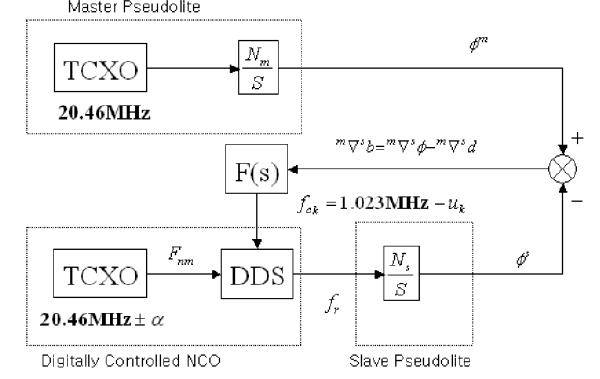
Figure 3. Control Block Diagram of Pseudolite Clock Synchronization